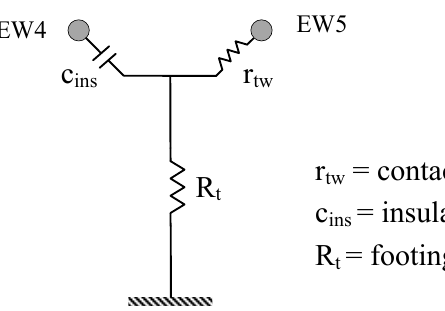
Figure A4. EW4 insulation from